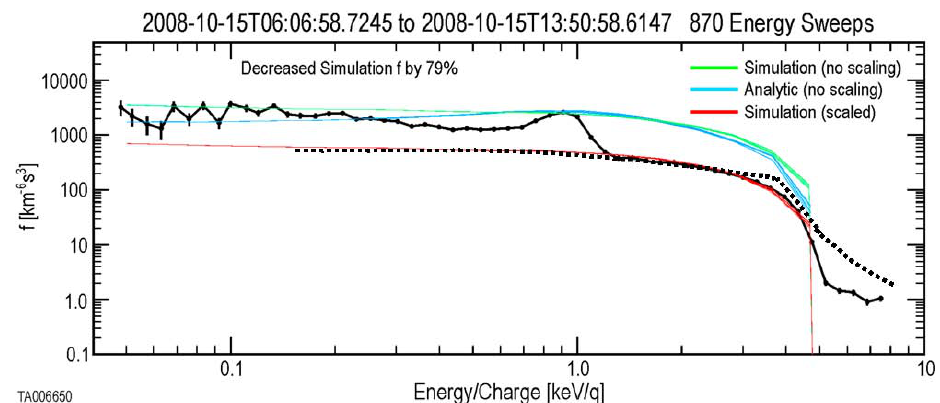
Fig. 5. The (PUI) distribution function as a function of energy per charge as measured with the New Horizon’s spacecraft (black solid line; McComas et al., 2010). The blue line is an analytical approximation using the model by Vasyliunas and Siscoe (1976); the yellow/red line indicates the unscaled/scaled simulation result obtained by McComas et al. (2010), and the black dotted line is our (arbitrarily shifted) result (Figure adopted from McComas et al.,